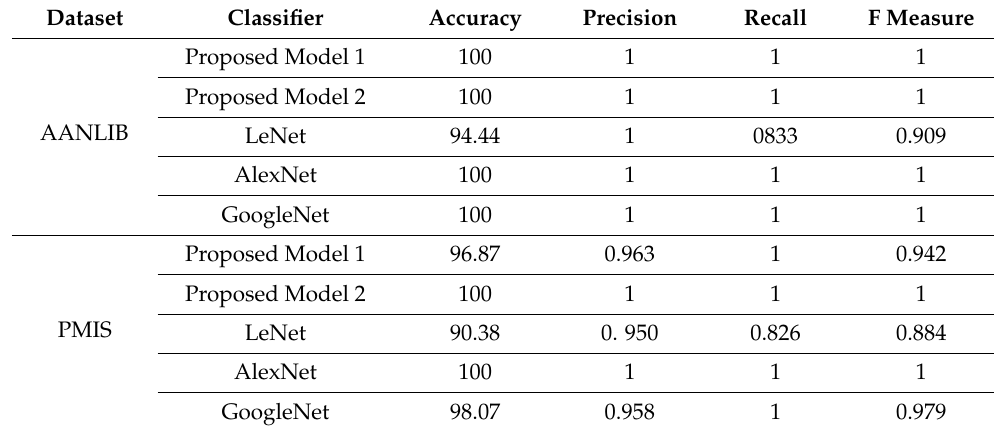
Table 9. Experimental Results for Validation Datasets (PMIS-MRI and AANLIB).